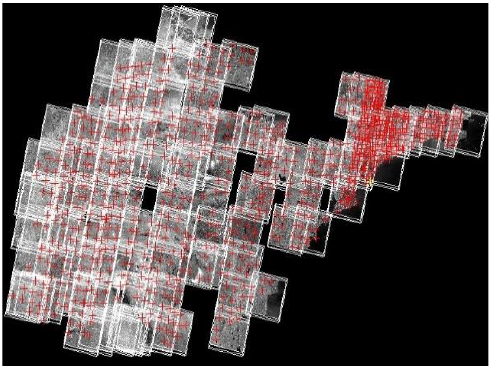
Figure 3. Distribution map of high precision GPS checkpoints in the experimental area